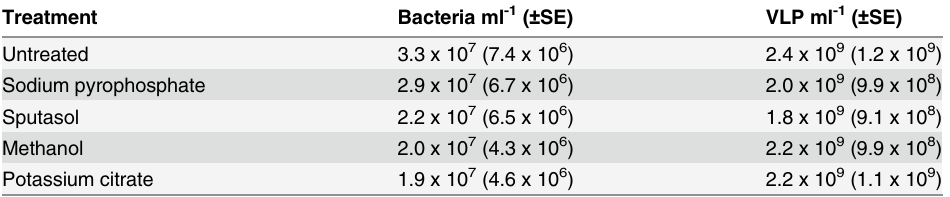
Table 1. Mean concentration of bacteria and VLP per ml of sinus flush fluid for each treatment method tested. Error represents standard error of the mean.